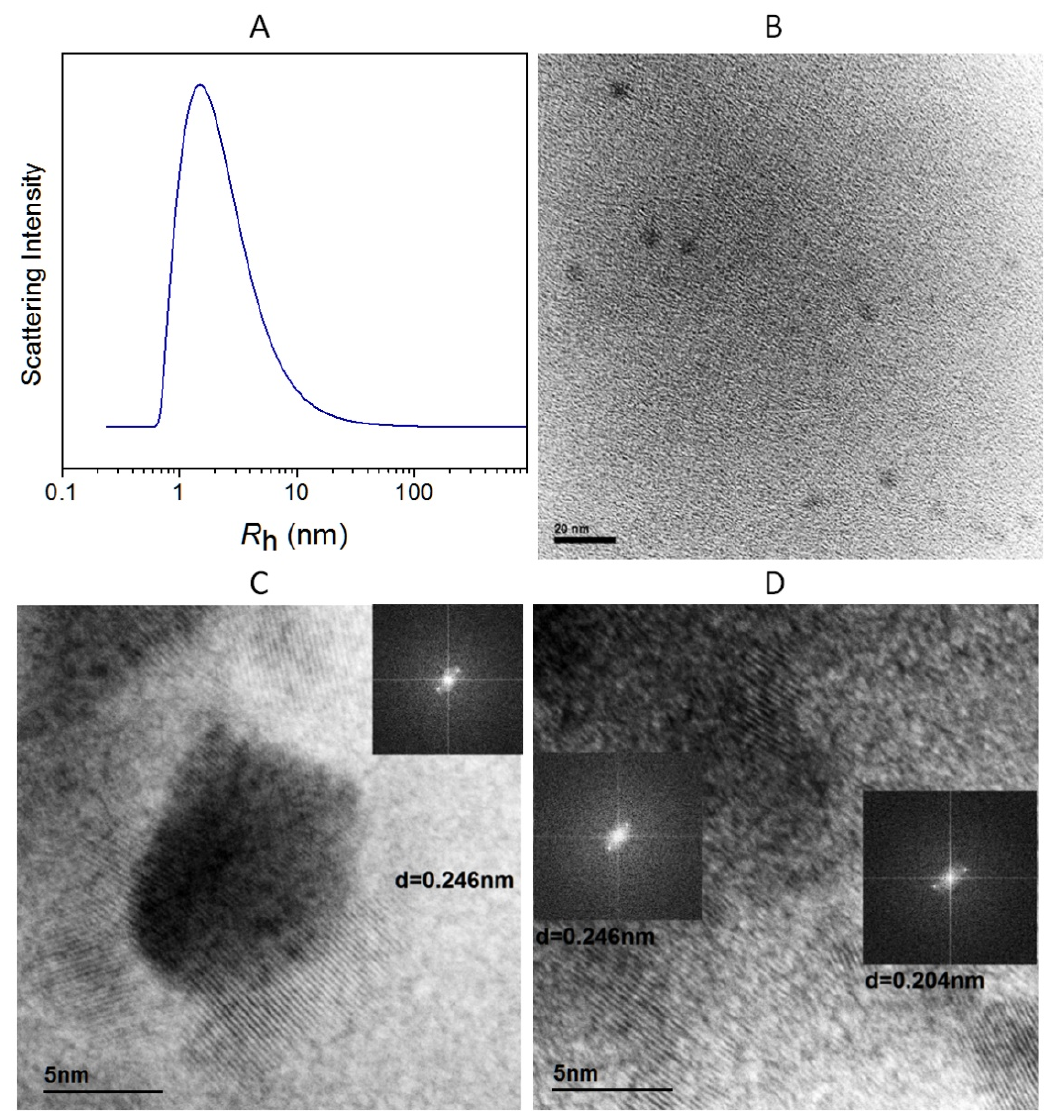
Figure 1. ( A ) Hydrodynamic size distribution of N-doped CDs. ( B ) TEM bright-field images of N-doped CDs; scale bar: 20nm. ( C ) and ( D ) High-resolution TEM (HRTEM) images of N-doped CDs. The insets are the corresponding fast Fourier transform (FFT) patterns.